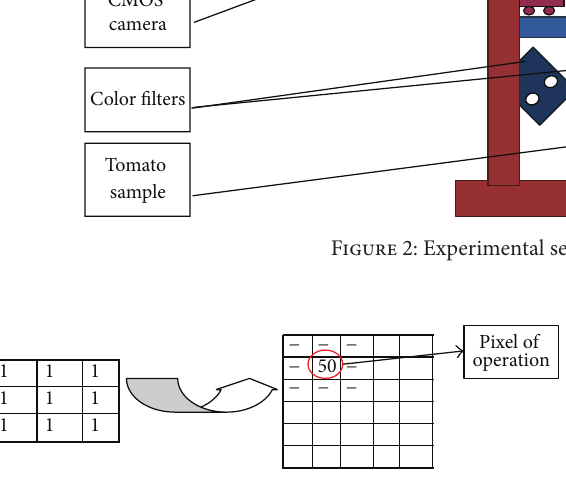
Figure 3: Rank order filter used for noise removal process.